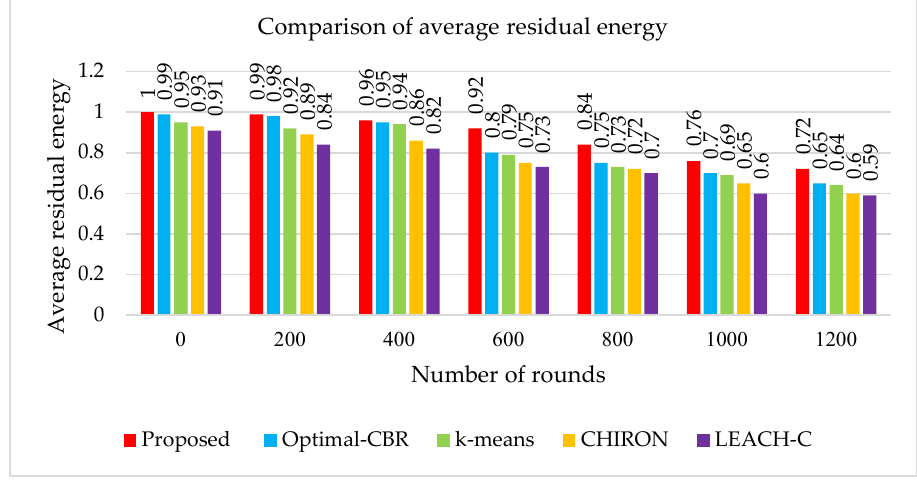
Figure 2. Comparative analysis between the proposed methods and several other methods.